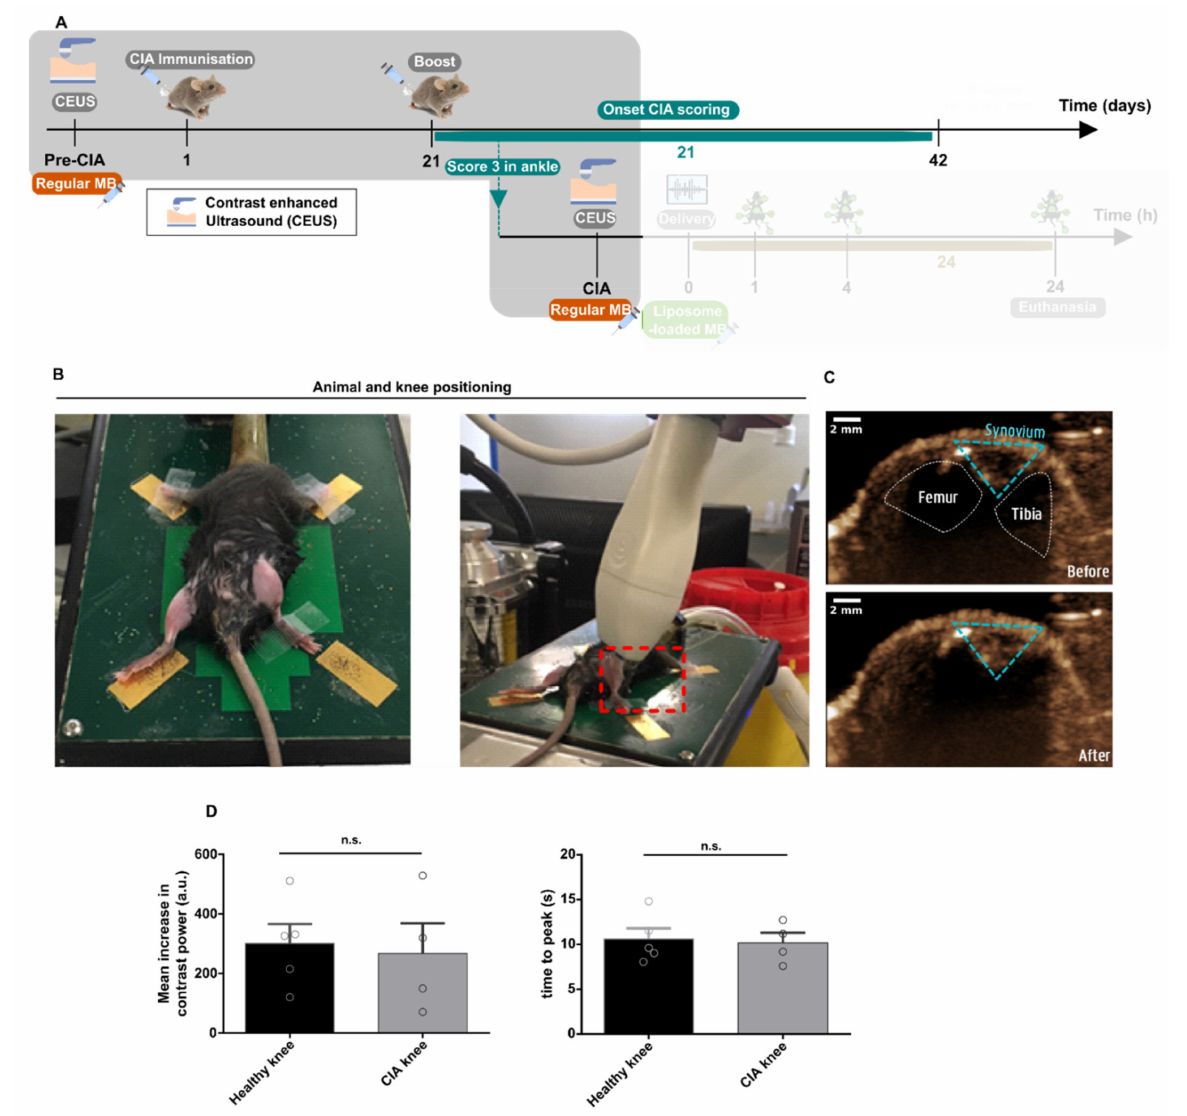
Figure 2. CEUS imaging of inflamed synovium in healthy and CIA mice. ( A ) Timeline of the experimental study and visualization of the imaging experiment (grey box): CEUS imaging of the knee joints of healthy mice (‘pre-CIA’) was performed to quantify microbubble influx before CIA induction. Subsequently, CIA was induced by intradermal injection of a collagen emulsion (day 1) or booster injection (day 21). Only mice that reached a visual CIA score of 3 in at least one ankle were included in the follow-up study. The knee synovium of mice with a visual score of 3 in the ankle joint was imaged with CEUS (grey). ( B ) Example of the experimental set-up for ultrasound imaging and treatment in C57BL/6, the mouse was placed supine and the knee was tilted and fixed at a ninety-degree angle to allow ultrasound imaging of the synovial cavity. The ultrasound probe was positioned perpendicular to the tilted knee (red square) in line with the position of the femur. ( C ) CEUS image before (upper image) and 10 s after microbubble injection (lower image) of the knee synovium (dotted line) in DBA/1 mice. ( D ) Quantitative analysis of the CEUS images of healthy (grey bars, n = 5) and inflamed knees (black bars, n = 4) of DBA:1 mice, each dot represents one mouse: mean increase in contrast power ( left graph ) and time to peak ( right graph ), compared via a paired t